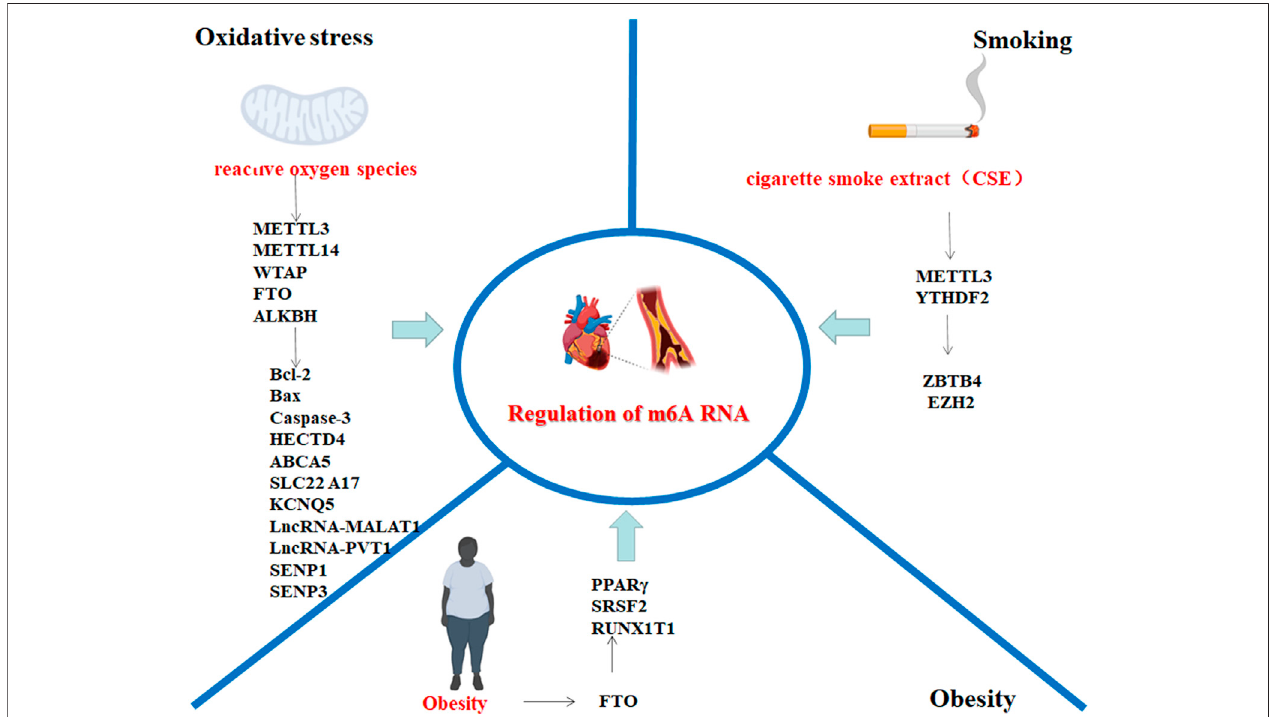
FIGURE 2| AS riskfactors involved in the regulation ofm6A methylation-related target genes; the picture wascreated with BioRender. The genes associated with oxidative stress and m6A RNA modi fi cation include HECTD4, ABCA5, SLC22A17, KCNQ5, lncRNA-MALAT1, and lncRNA-PVT1; genes associated with obesity and m6ARNAmodi fi cationincludeSRSF2andPPAR- γ ;andgenesassociatedwithsmokingandm6Amodi fi cationincludeZBTB4,EZH2andH3K27me3.Theabovegenes may be involved in m6A RNA modi fi cation, which may be involved in the AS disease process. The schematic diagram was created with BioRender.